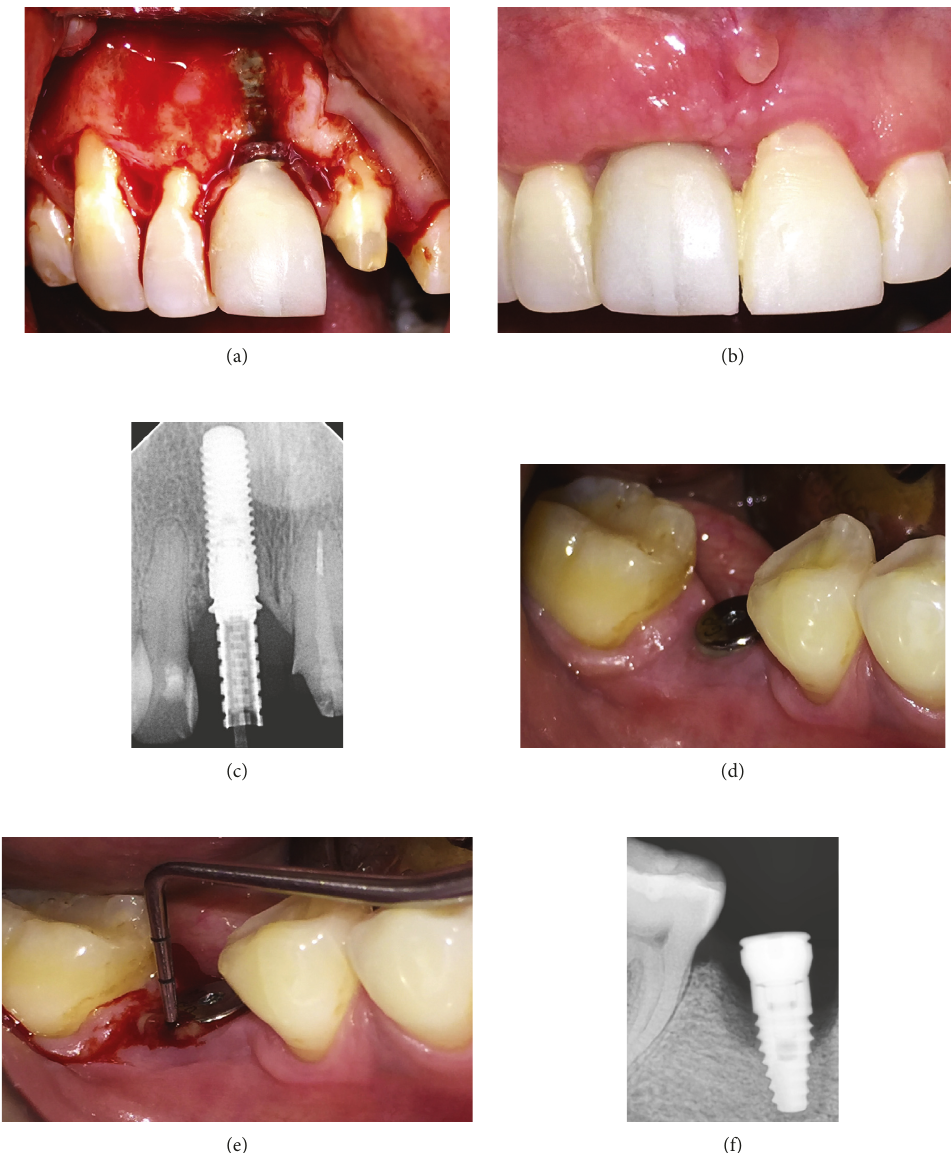
Figure 2: Failure cases. Patient 3: exploratory surgical procedure for peri-implantitis (a), soft tissues after a bone graft healing (b), and periapical X-ray after 4 months (c). Patient 4: intraoral photography of implant (d), periodontal probing (e), and periapical X-ray showing vertical bone loss around implant